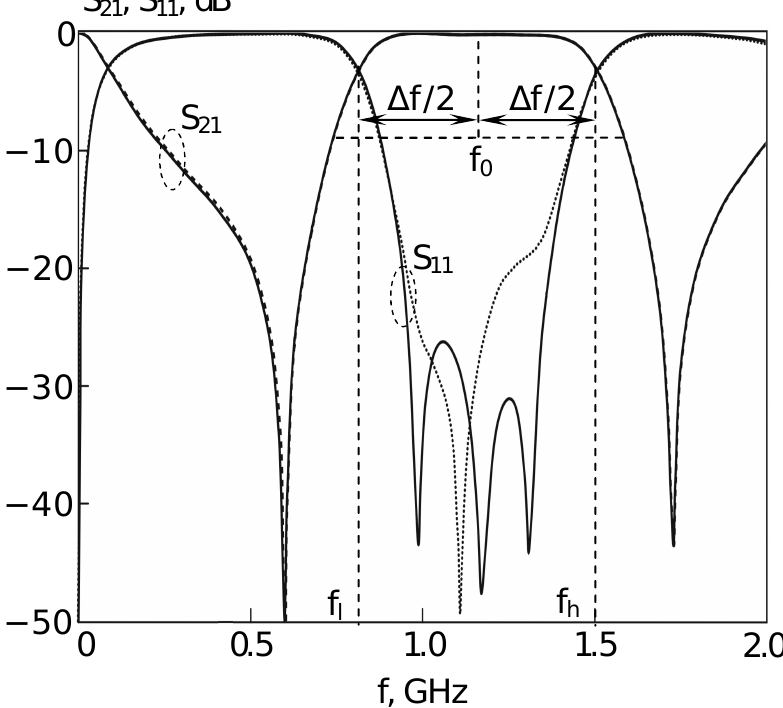
Figure 2. AFC of the U-shaped 3-mode (slot-split rectangular) resonator. Points—experimental data, lines—theoretical data (results of electrodynamic